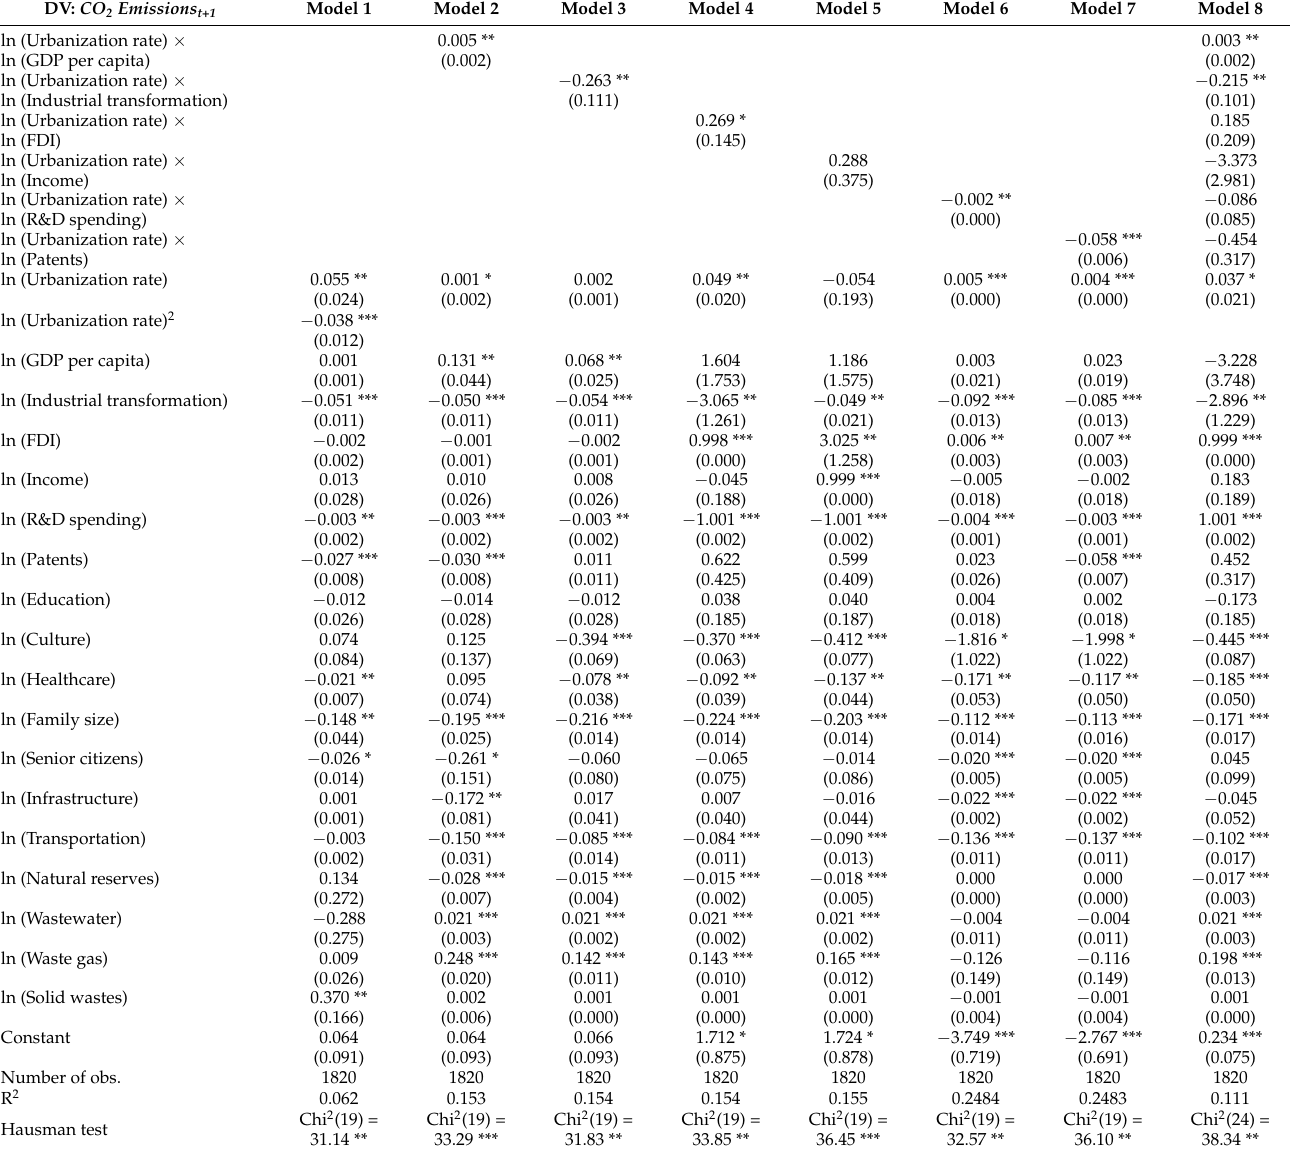
Table 4. Moderating effects of economic factors on the relationship between urbanization and carbon dioxide